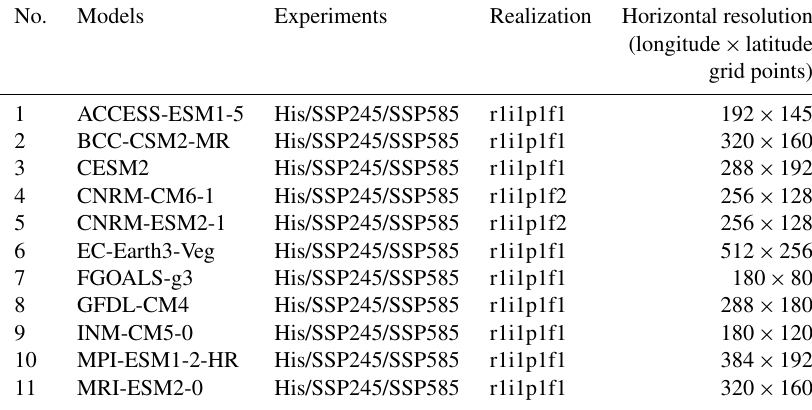
Table 1. CMIP6 simulations used in this study. “His” means historical simulations during 1979–2014 with both anthropogenic and natural forcings; SSP245 and SSP585 represent two Shared Socioeconomic Pathways during 2015–2100. Note the CNRM-CM6-1 and